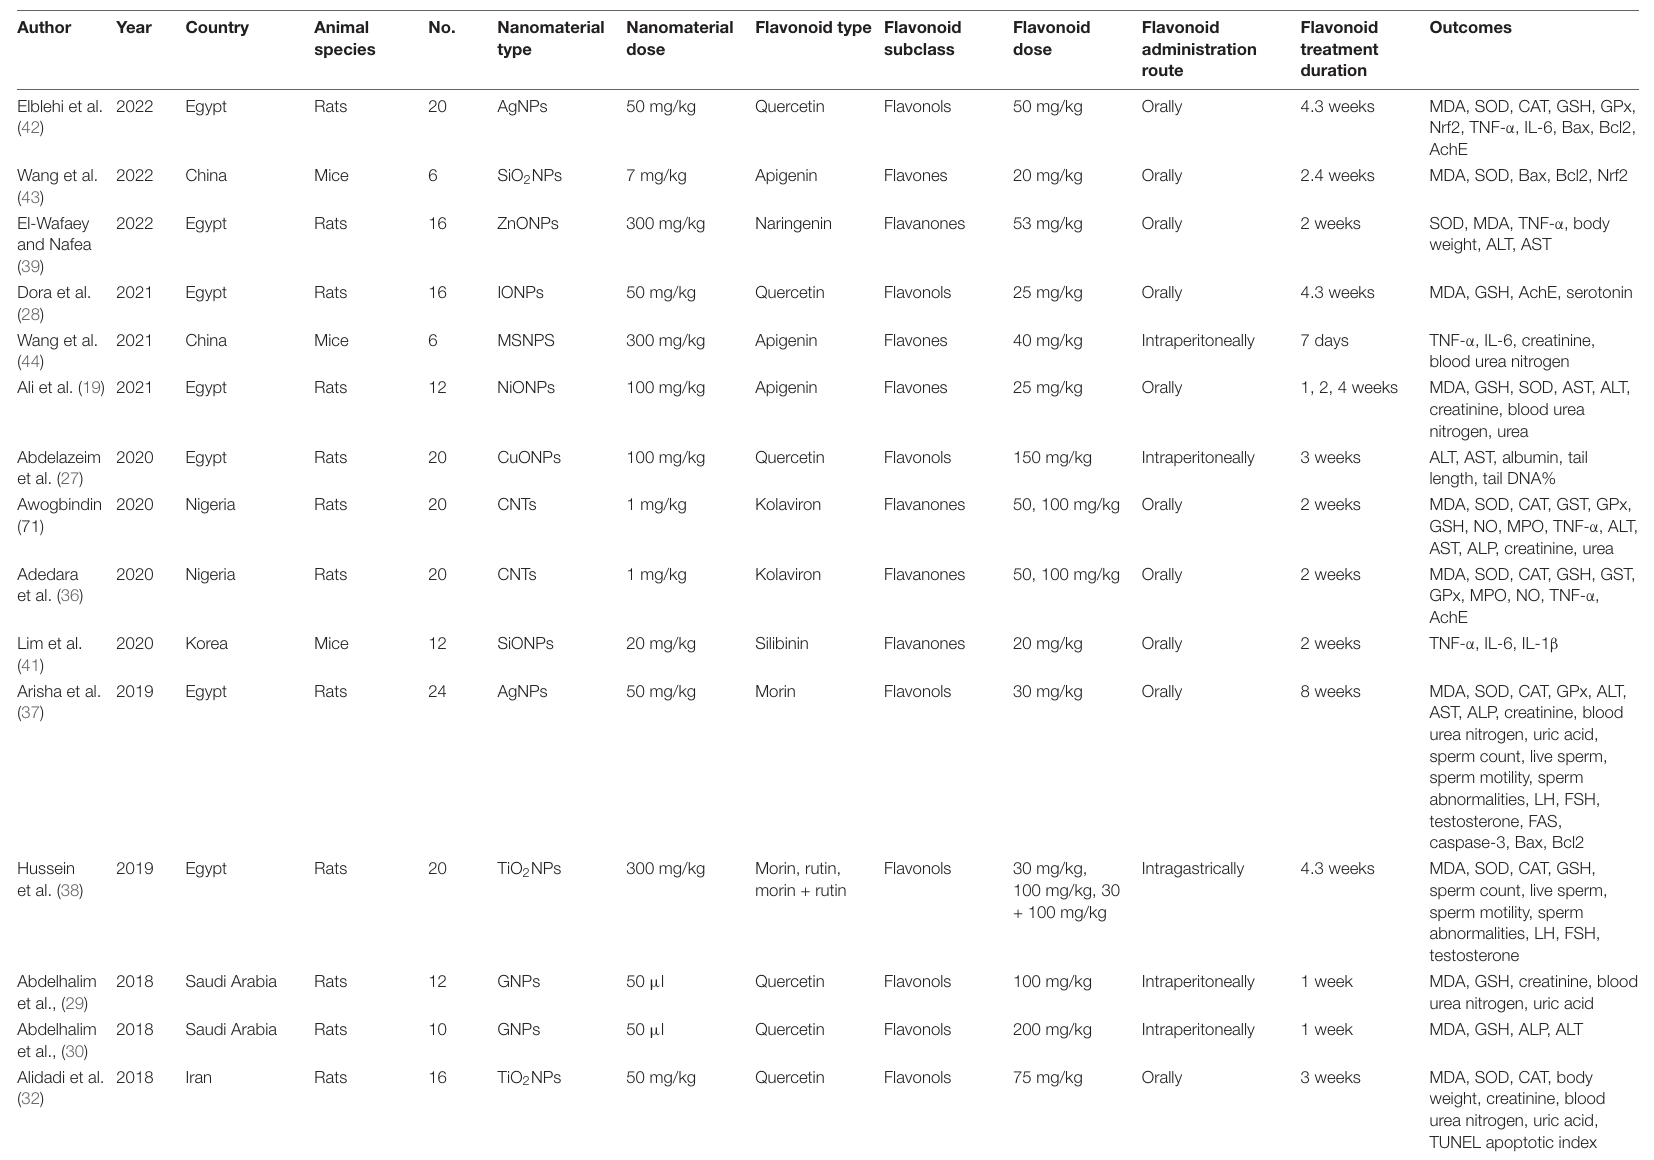
TABLE 1 | Basic characteristics of the included